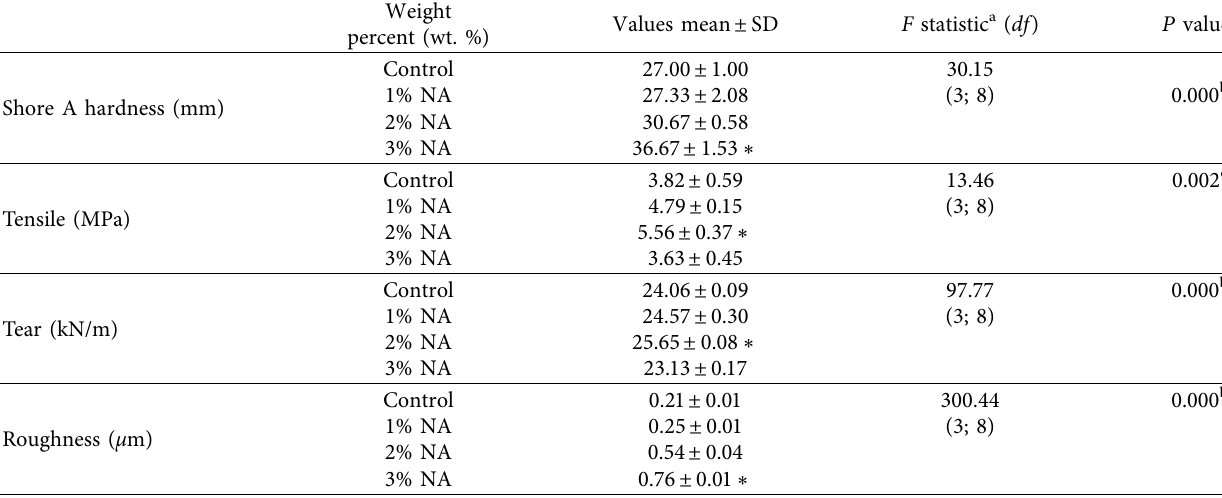
Table 2: Te comparison of 1%, 2%, and 3% wt. nanoalumina (NA) addition on Tech-sil25 maxillofacial silicone mechanical properties.